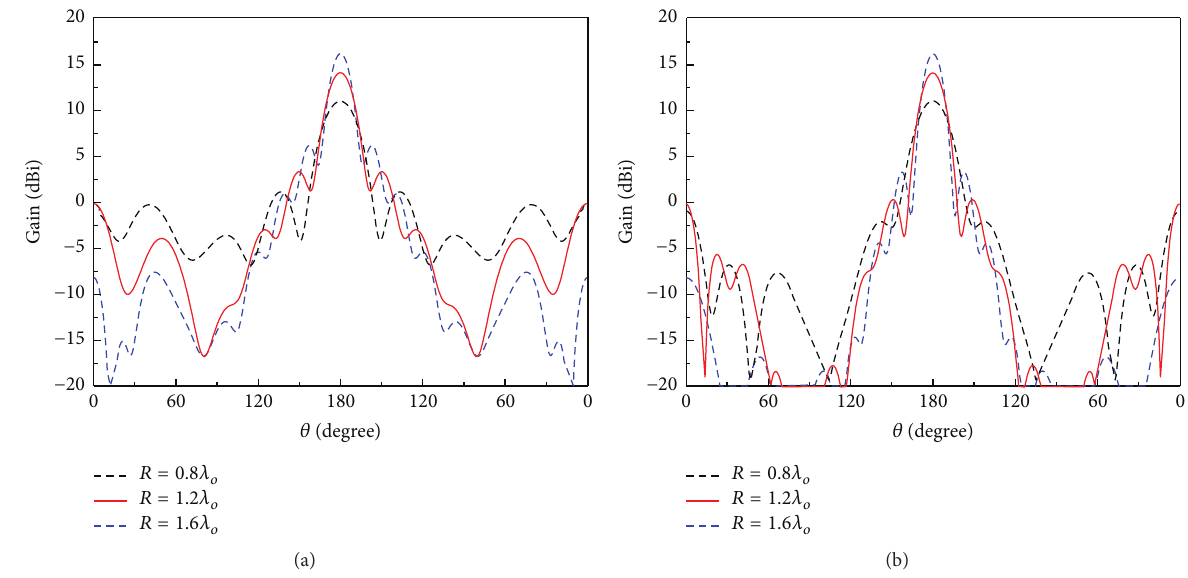
Figure 4: Radiation patterns of the antenna for different lens radii with fixed 𝑇/𝑅 = 0.34 at 0.3 THz: (a) 𝑥𝑧 -plane and (b) 𝑦𝑧 -plane.